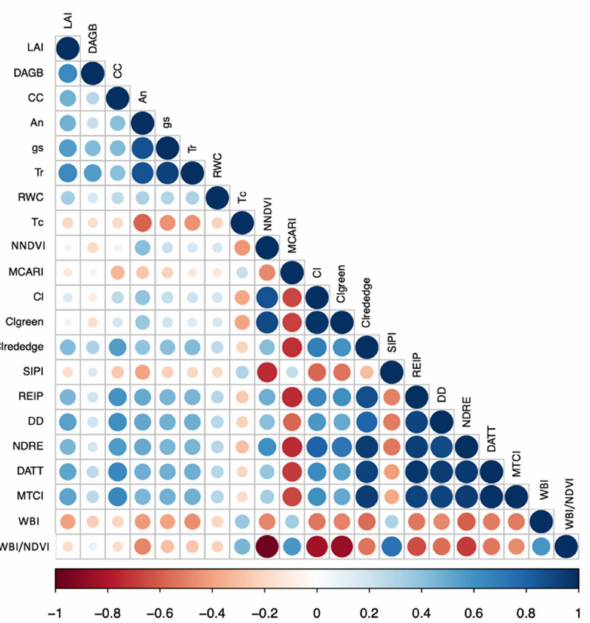
Figure 5. The correlation matrix for the bio-physiological parameters and vegetation indices for sweet maize.